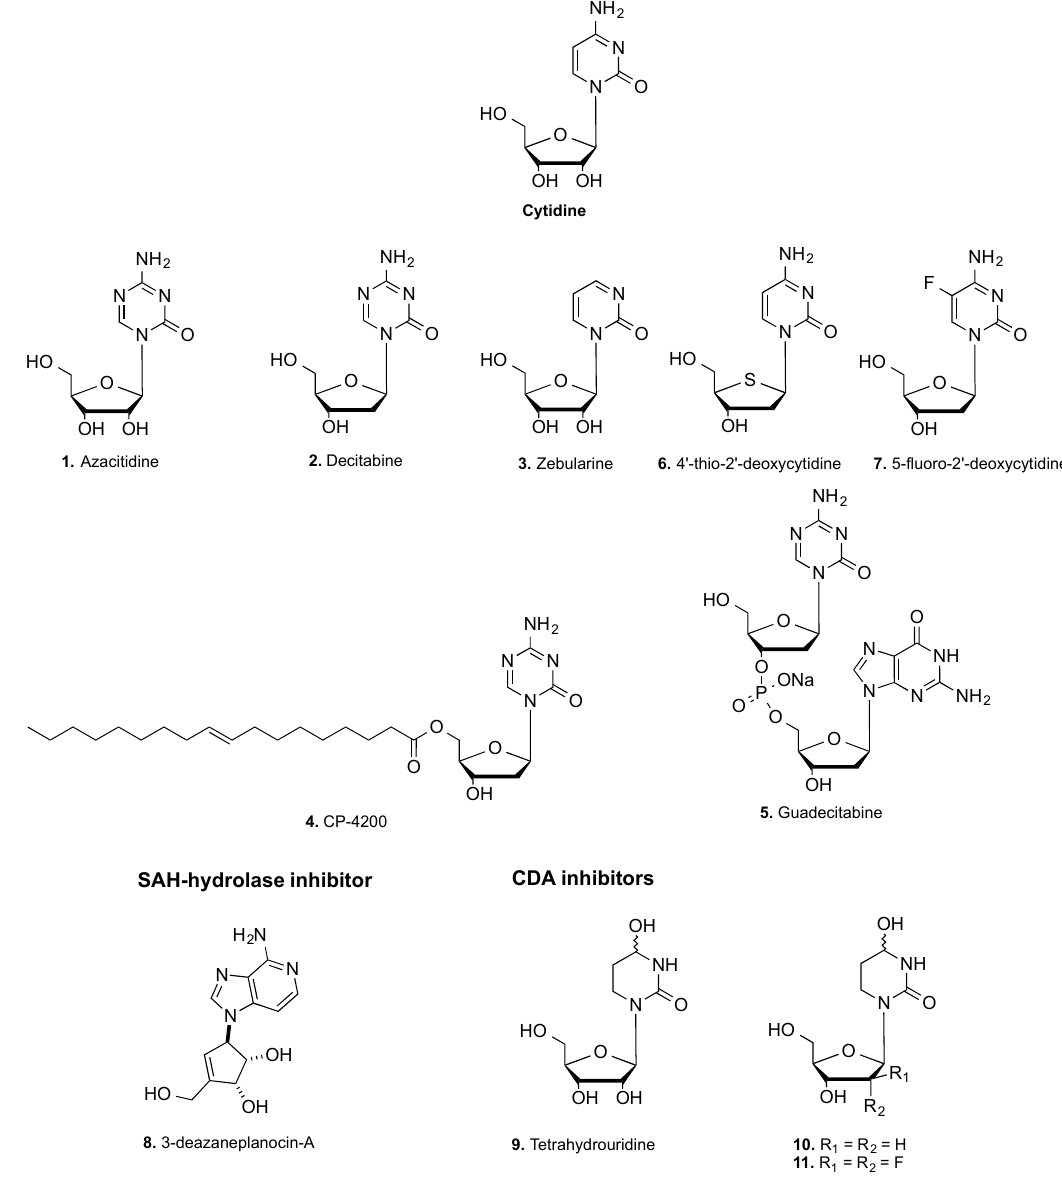
Figure 2. Structures of nucleoside DNMT, S -adenosyl-L-homocysteine (SAH)-hydrolase and cytidine deaminase (CDA) inhibitors.